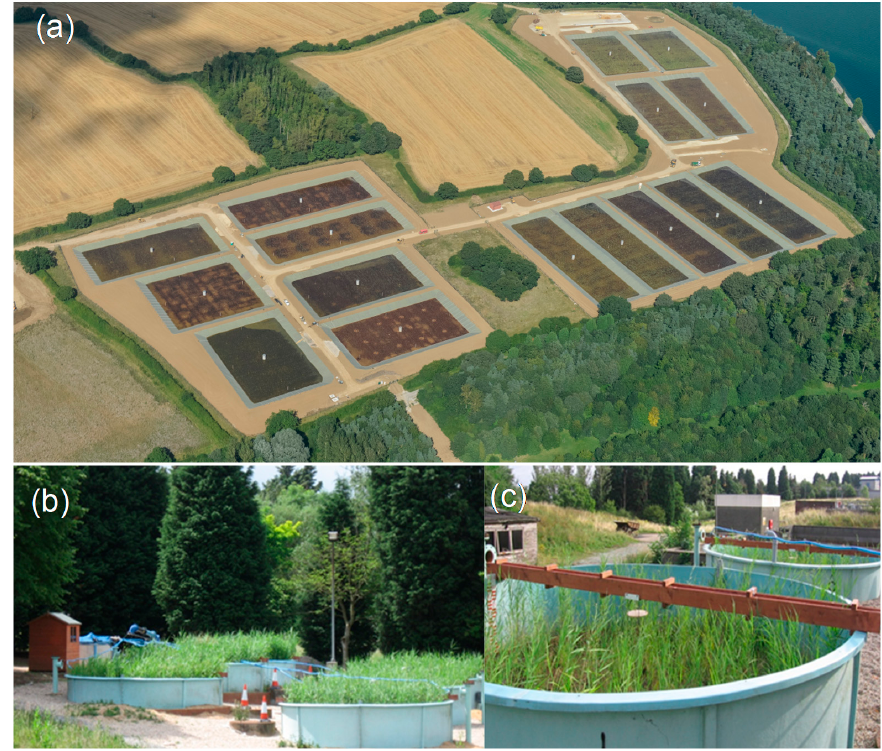
Figure 8. ( a ) Full-scale and ( b , c ) pilot-scale STRB systems [38,59] at Hanningfield (England) for water works sludge dewatering (courtesy of Orbicon). Table 3. STRBs in England for water works sludge treatment (P = pilot, F = full-scale, FS = ferric sludge, AS = alum sludge, WW = Water Works) [45,53,60].